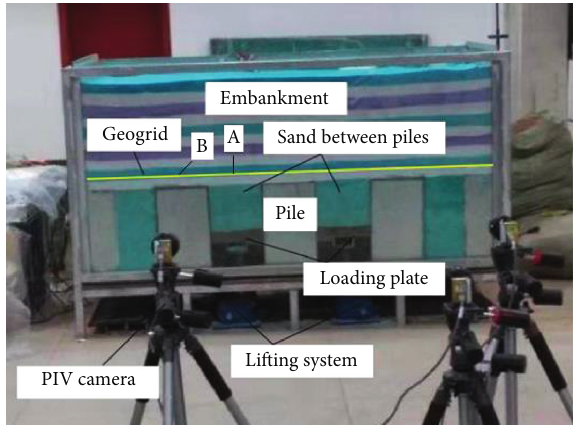
Figure 2: Model test